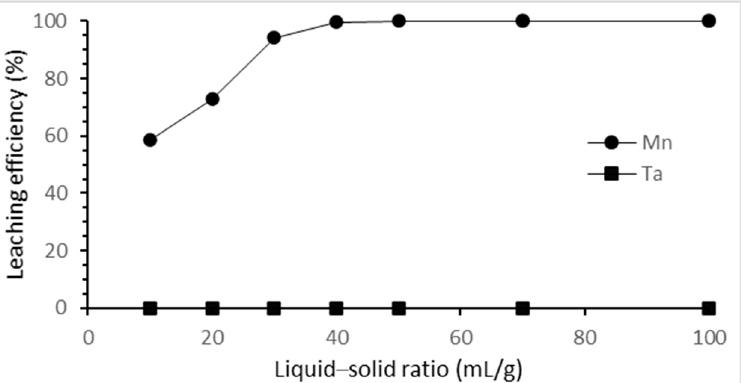
Figure 5. Effect of liquid–solid ratio on the selective leaching efficiency. (HCl concentration: 3 M; reaction time: 3 h; reaction temperature: 25 °C).